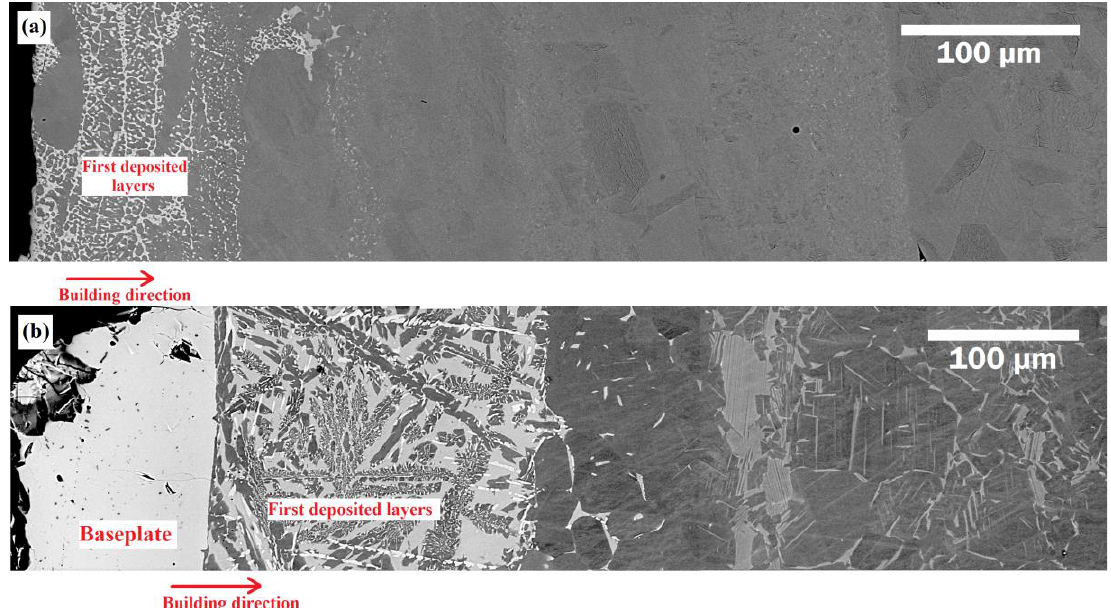
Figure 2. SEM micrographs of ( a ) as-built and ( b ) HIPed samples along the building